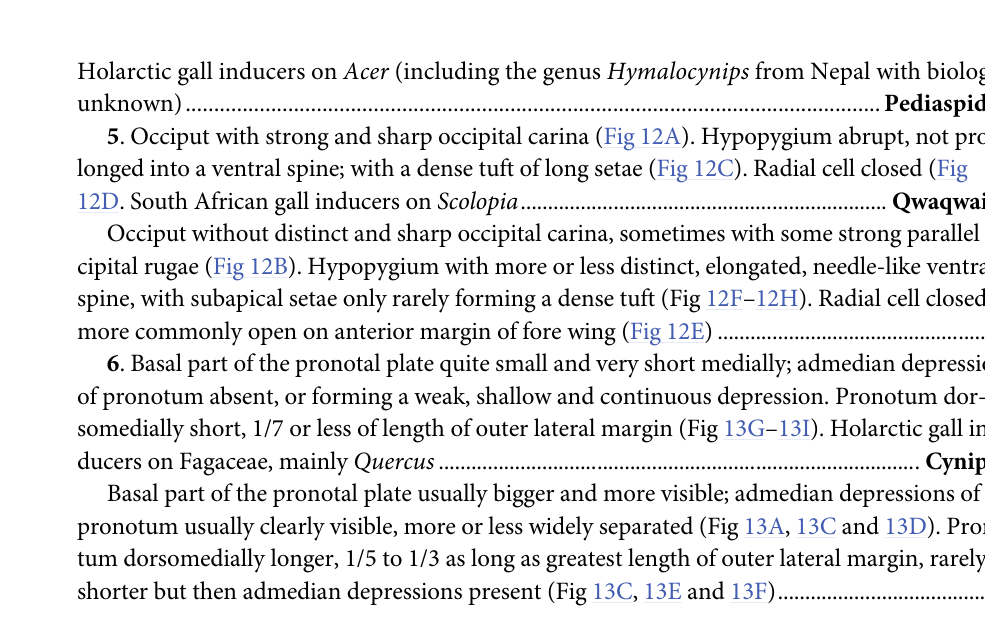
Fig 13. Pronotal chracters of tribes of Cynipidae. Pronotum in anterior view of: A) Neaylax versicolor Nieves-Aldrey. B) Phanacis centaureae Förster. C) Aylax papaveris (Perris). D) Diastrophus rubi . E) Lithonecrus papuanus Nieves-Aldrey. F) Synergus ibericus Tavares. G) Callirhytis cameroni Medianero & Nieves-Aldrey. H) Andricus curvator Hartig bisex. gen. I) Cynips divisa Hartig parth. gen.